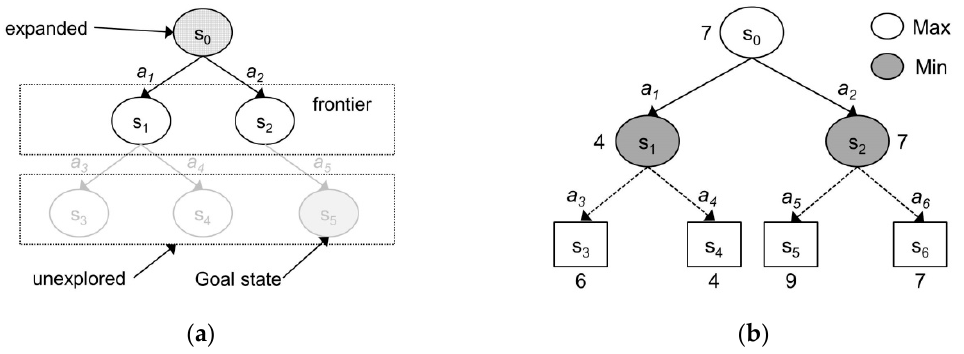
Figure 5. Two examples of search trees: ( a ) A search tree depicting the expansion of the initial state s 0 into two new (child) states s 1 and s 2 (the frontier) derived by performing actions a 1 and a 2 , respectively; ( b ) A minimax tree. White nodes are max nodes (max’s turn is depicted with a solid line) whereas grey nodes are min nodes (min’s turn is depicted with a dashed line). Terminal nodes (squares) show the utility values for max. The remaining nodes show their minimax values. Max’s best move at the root is a 2 (highest minimax value of 7), given that it is assumed that min plays optimally (i.e., tries to minimize max’s score) and will therefore choose to perform action a 6 (lowest minimax value of 7). The branches of the tree can be thought of as corresponding to the strategies that both max (solid lines) and min (dashed lines) can choose from.